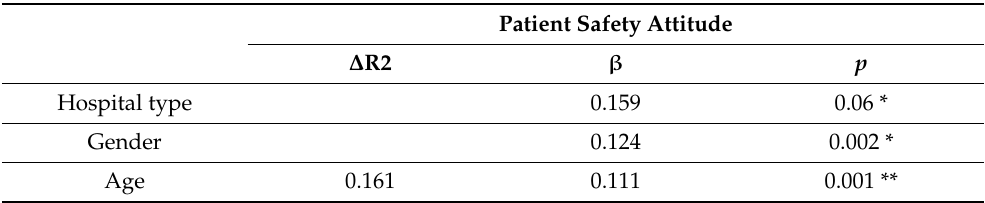
Table 5. Multiple linear regression analysis results: factors associated with patient safety attitude questionnaire